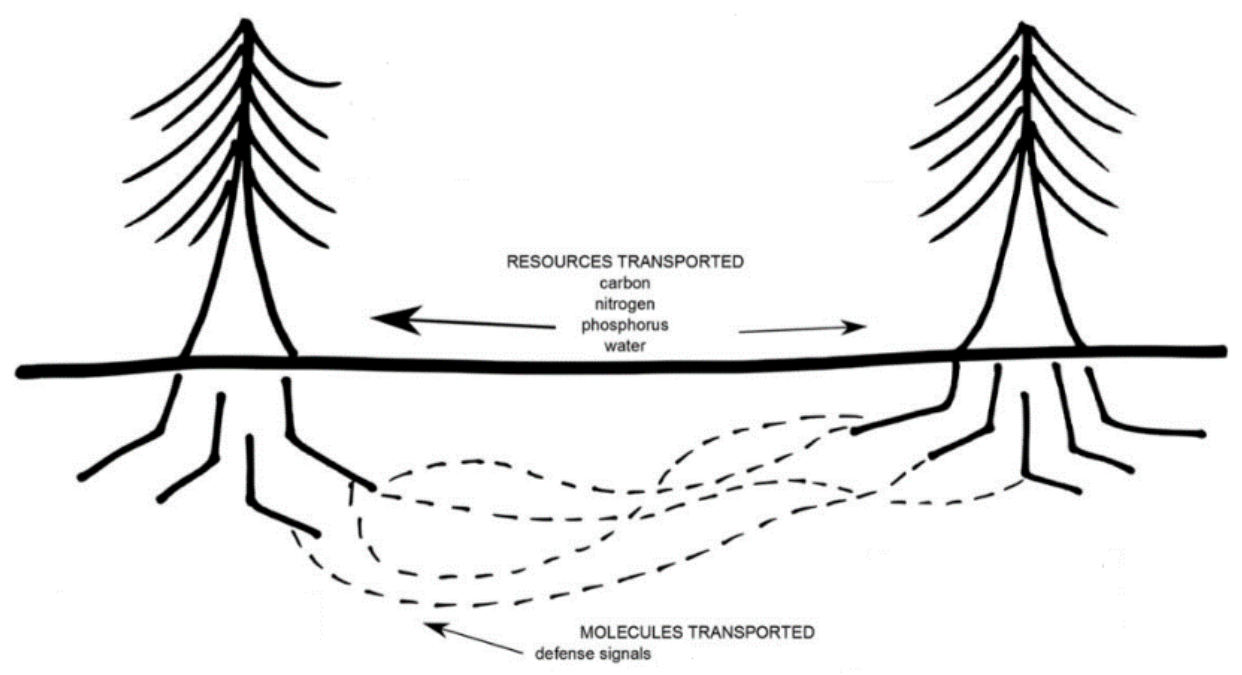
Figure 4. Signaling and resource exchange through MN. The Nobel optimization algorithm DMOA is inspired by the nature of the Mycorrhiza Network (MN) and plant roots with this intimate interaction between these two